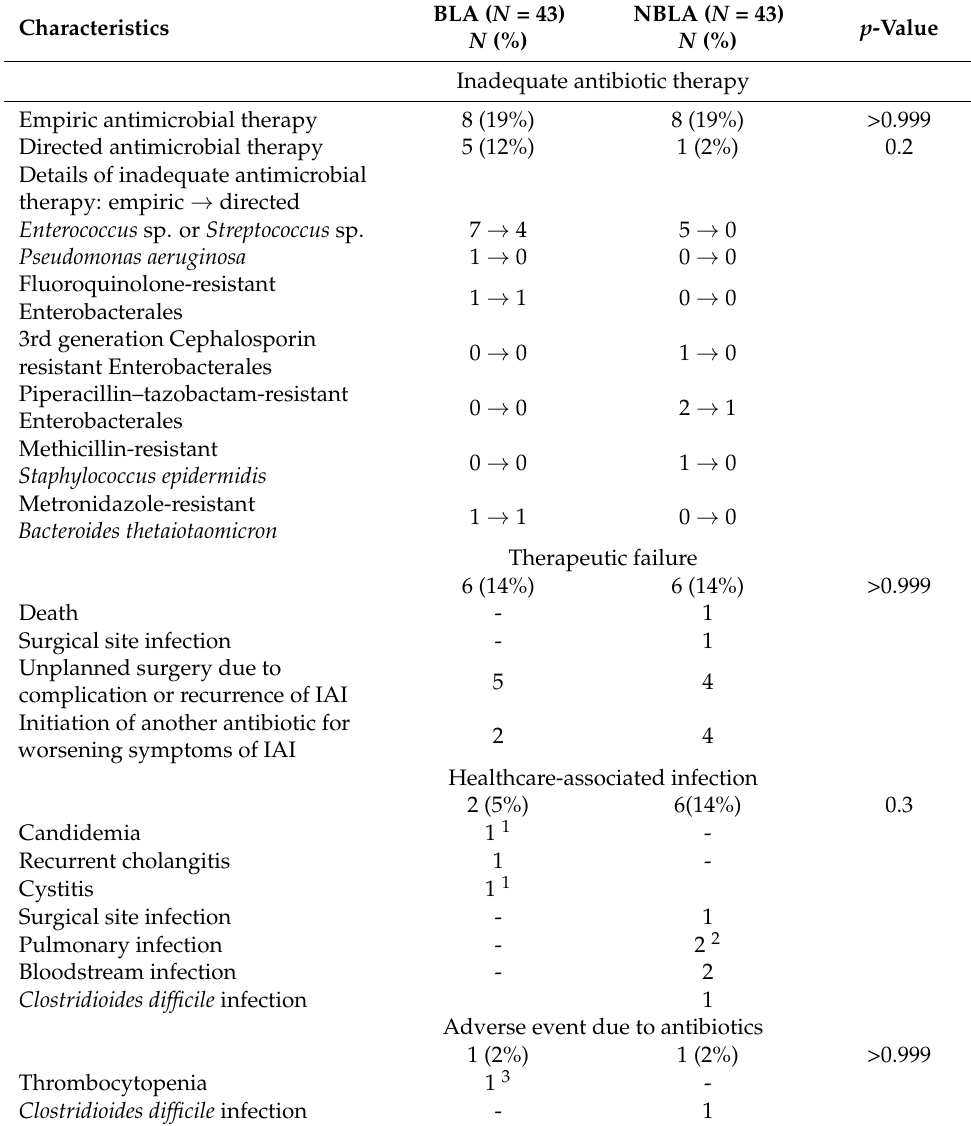
Table 3. Inadequate antimicrobial therapy, therapeutic failures, healthcare-associated infections, and antibiotic-related adverse